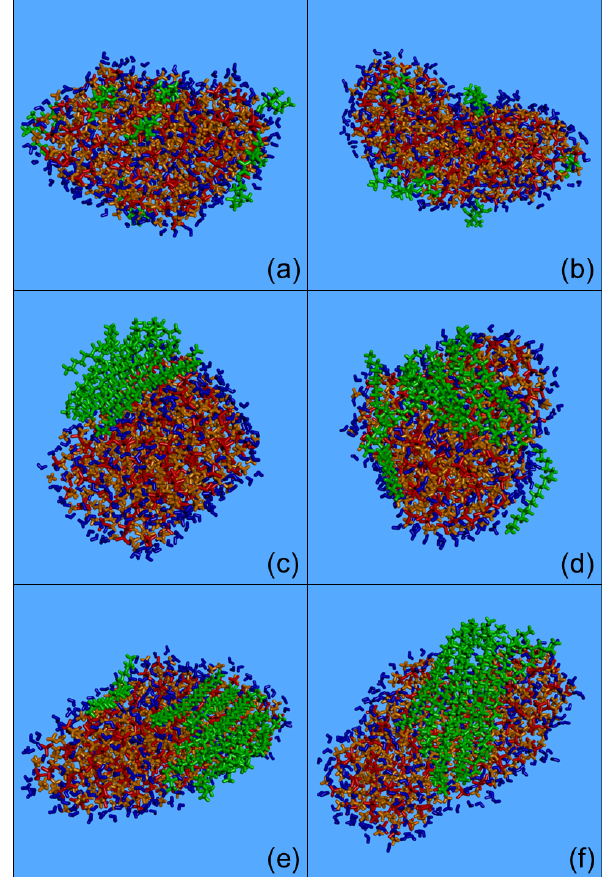
Figure 2. Typical snapshots of the nanoparticles composed of (green colour): (a) CPA, (b) MBTCA, (c, d) n -eicosane, (e) n - tetracosane and (f) n -triacontane and sulfate anions (red), ammo- nium cations (orange) and water molecules (blue) from the MD simulations. Conditions: low organic mass fraction (7%–14% dry) and 40%